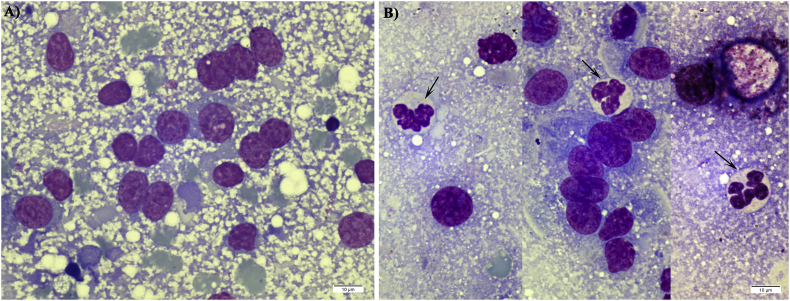
Giemsa stained mucosal scraping smears in C. suis infected piglets from group Wien-BKI (A) and Wien-Ctrl (B); Merozoites within parasitophorus vacuoles could be observed in smears from group Wien-Ctrl (arrows, B).